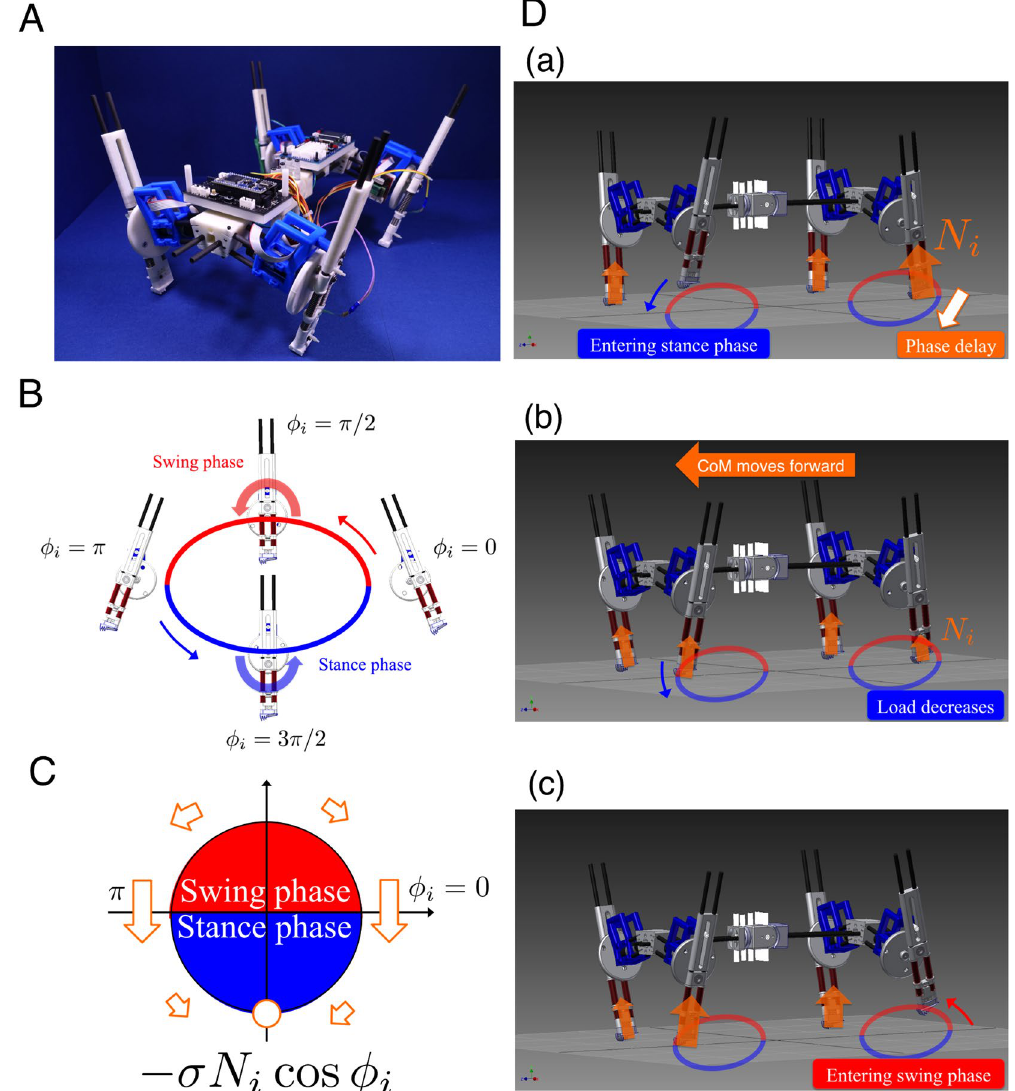
Figure 4. The quadruped robot, Oscillex 3 . ( A ) The robot is 0.25 m long and 0.20 m wide and weighs 2.0 kg. ( B ) Each leg has a DC motor to generate rhythmic swing-stance leg motion through a crank mechanism. ( C ) The feedback effect on the oscillator phase. ( D ) Interlimb coordination mechanism through physical communication